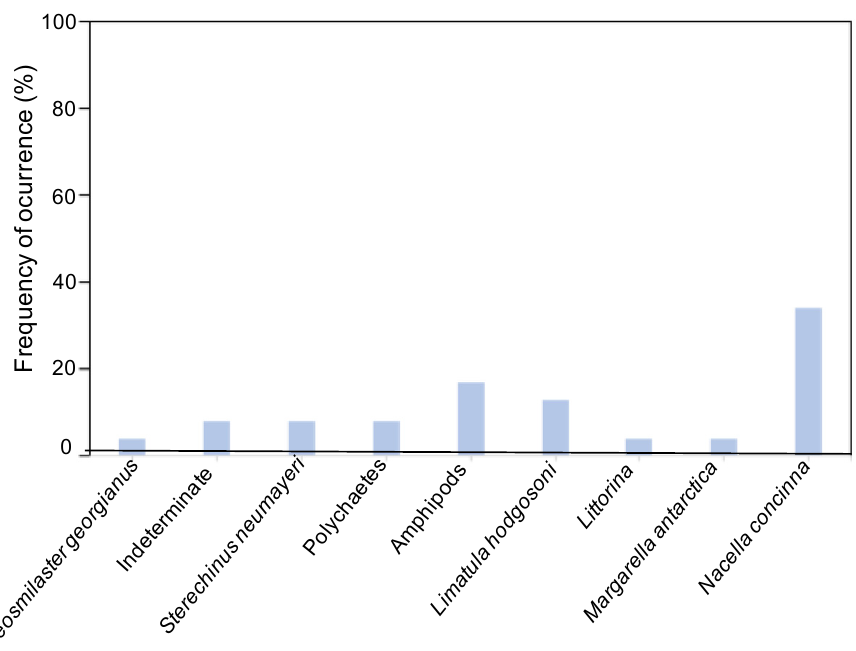
Figure 6. Frequency of occurrence of O. validus cardiac stomach everted contents from Ardley Cove.